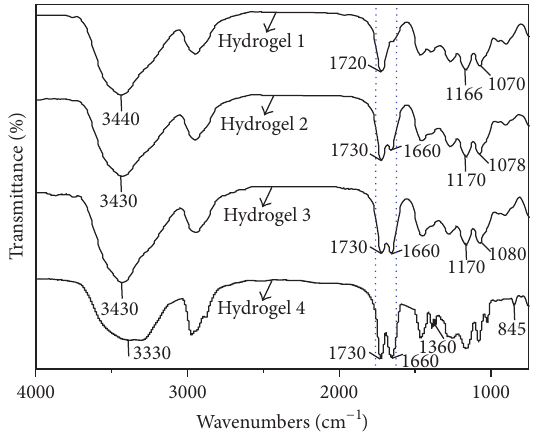
Figure 1: The IR spectra of hydrogels.